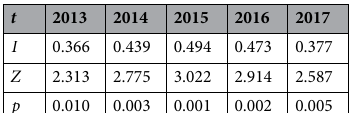
Geographic adjacency matrix Geographic distance matrix Indicators Parameter p value Parameter p